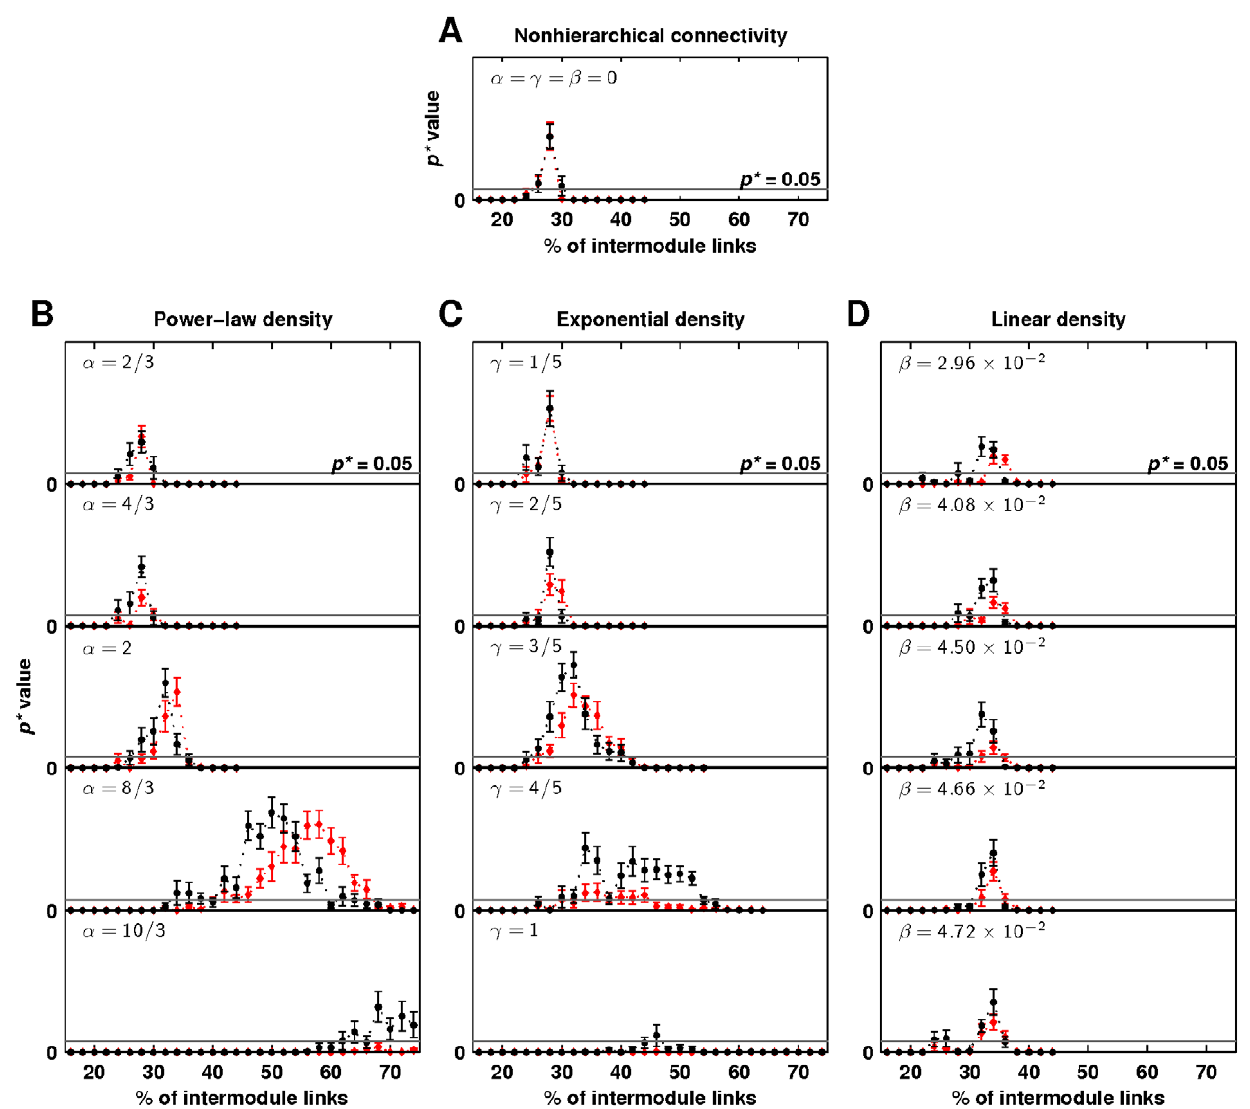
Figure 6. Relationship between hierarchical modularity, wiring cost and network dynamics. Statistical significance of power-law distributions of avalanche sizes (black) and durations (red) as a function of network randomization, for (a) nonhierarchical and hierarchical (b) power- law, (c) exponential and (d) linear density scaling functions. Gray lines show the p (cid:3) ~ 0 : 05 threshold for power-law scaling. Error bars represent the standard error of the mean from 20 simulations.